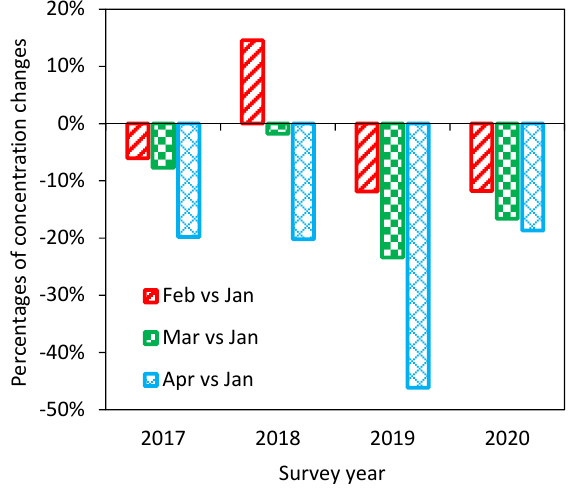
Figure 4. Percentages of roadside CO concentration changes of COVID-19 period (i.e., February–April) relative to pre-COVID-19 period (i.e., January) for each year.